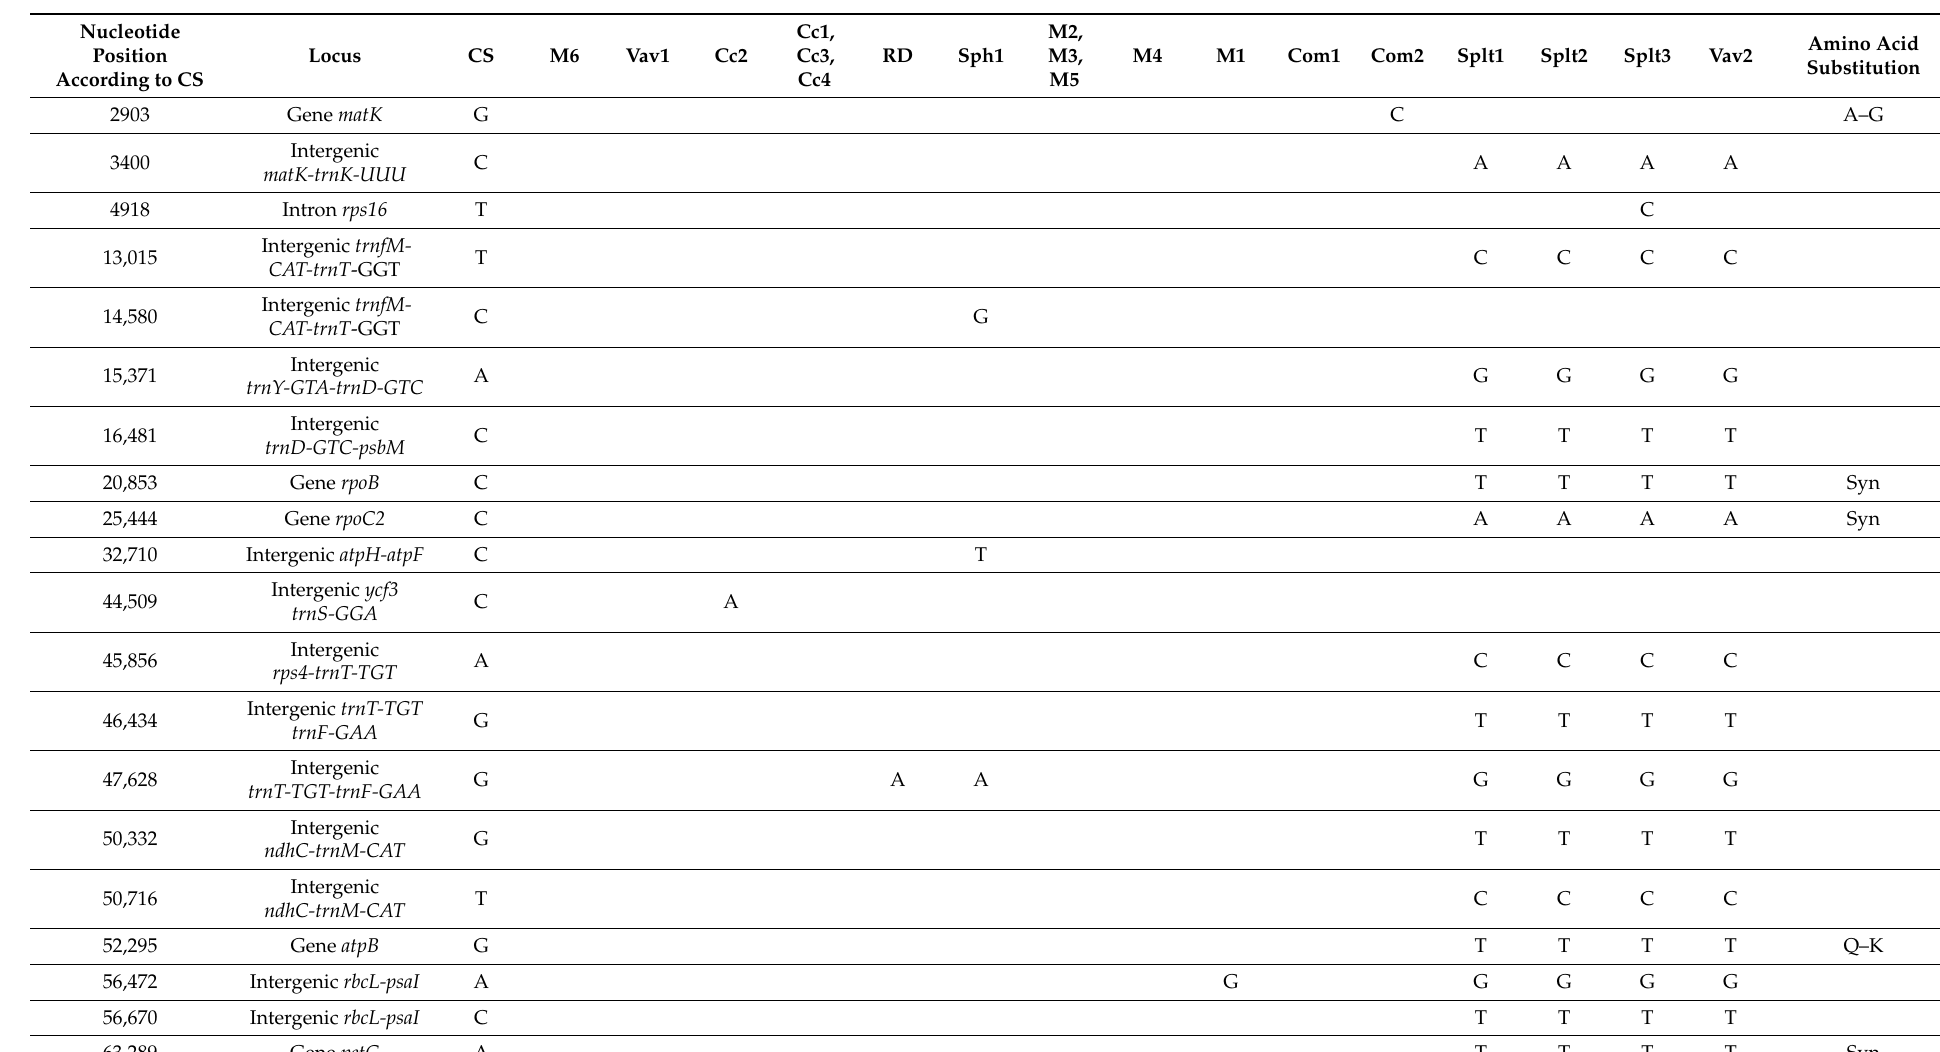
Table 4. SNPs specific for chloroplast DNA of hexaploid